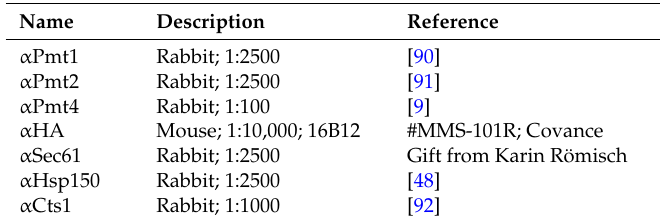
Table 4. Primary antibodies used in this